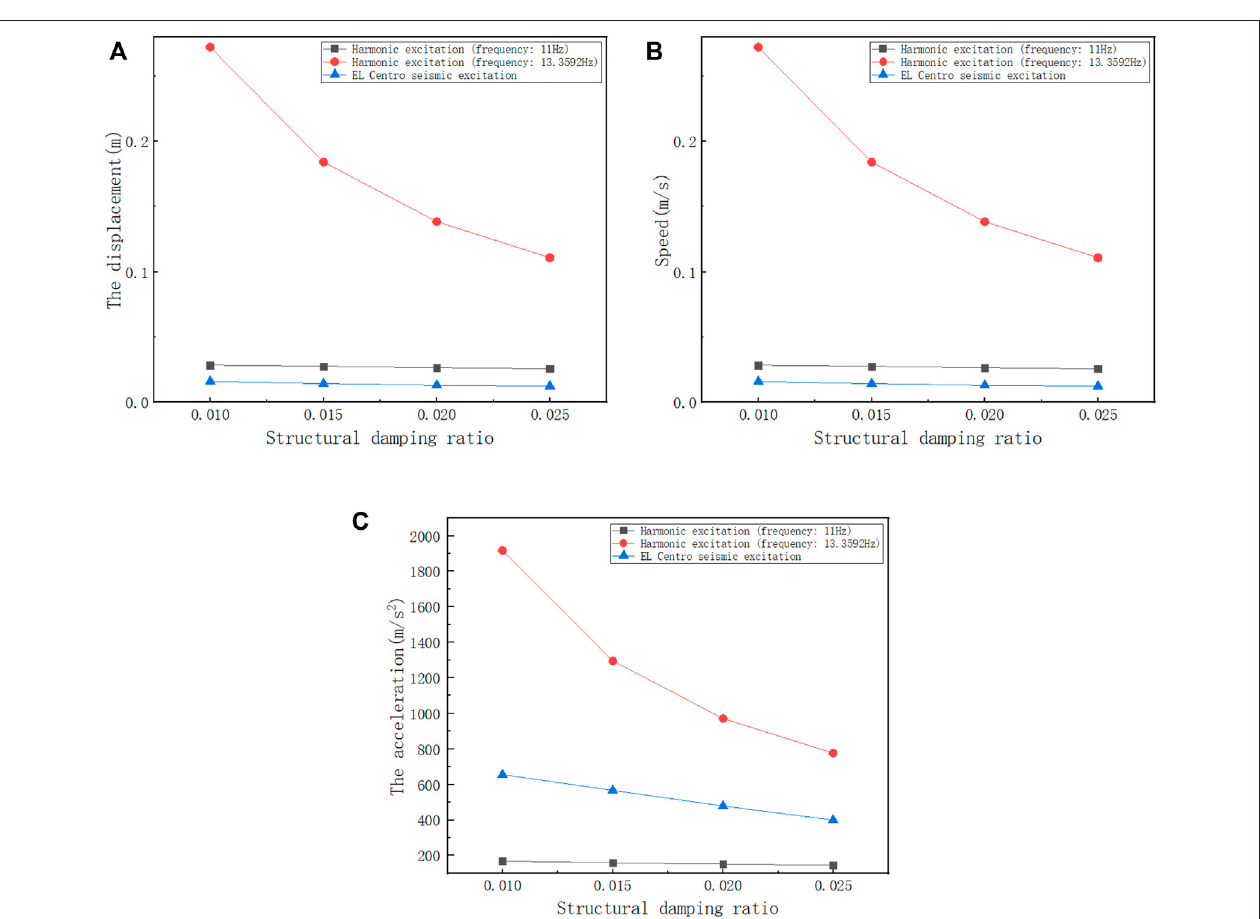
FIGURE11|(A) Relationshipbetweenthedampingratioanddisplacement. (B) Relationshipbetweenthedampingratioandvelocity. (C) Relationshipbetweenthe damping ratio and